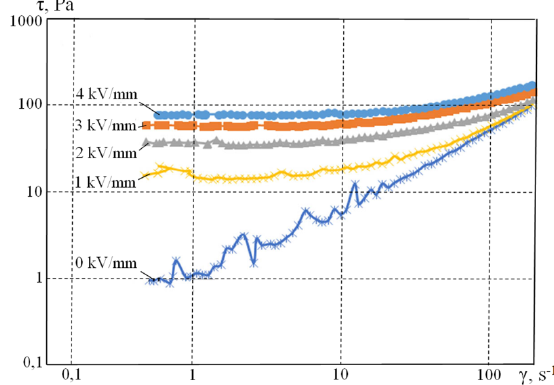
Figure 5. The dependence of stress versus the shear rate of the suspension PI-Na . Polymers 2020 , 12 , x FOR PEER REVIEW